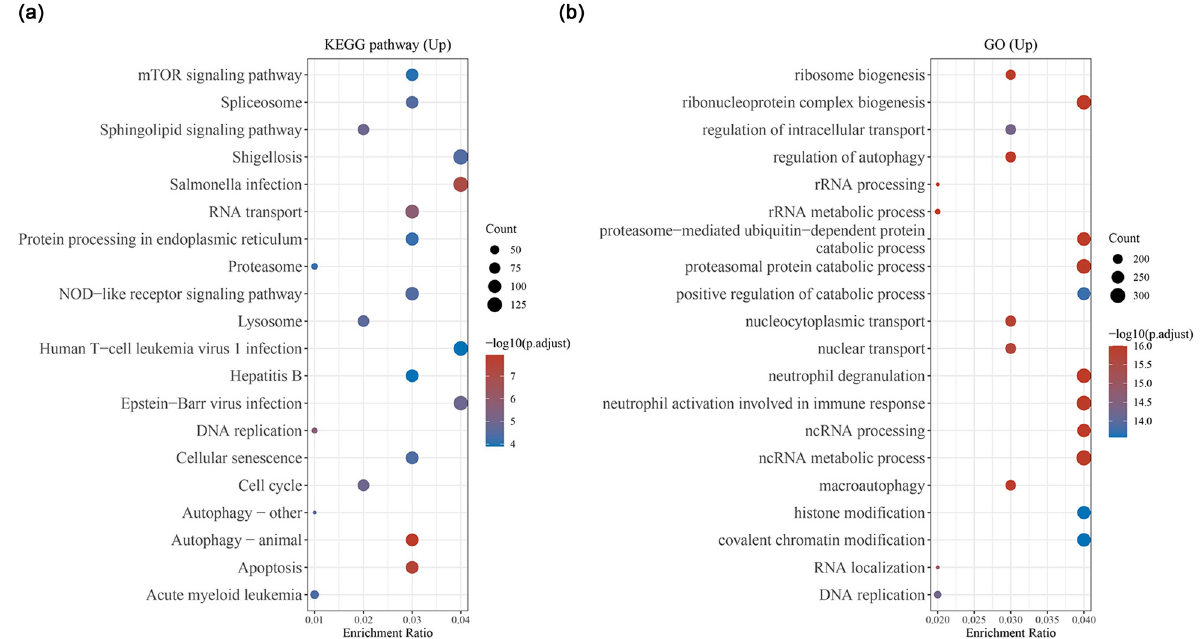
Figure 2: KEGG and GO analyses of upregulated genes in GSE73953 dataset. ( a ) KEGG analysis of signaling pathway enrichment in upregulated genes ( https://www.kegg.jp/ ) . ( b ) GO analysis of upregulated gene functional enrichment ( http://geneontology.org/ ) . Abbreviation: KEGG, Kyoto encyclopedia of genes and genomes; GO, gene